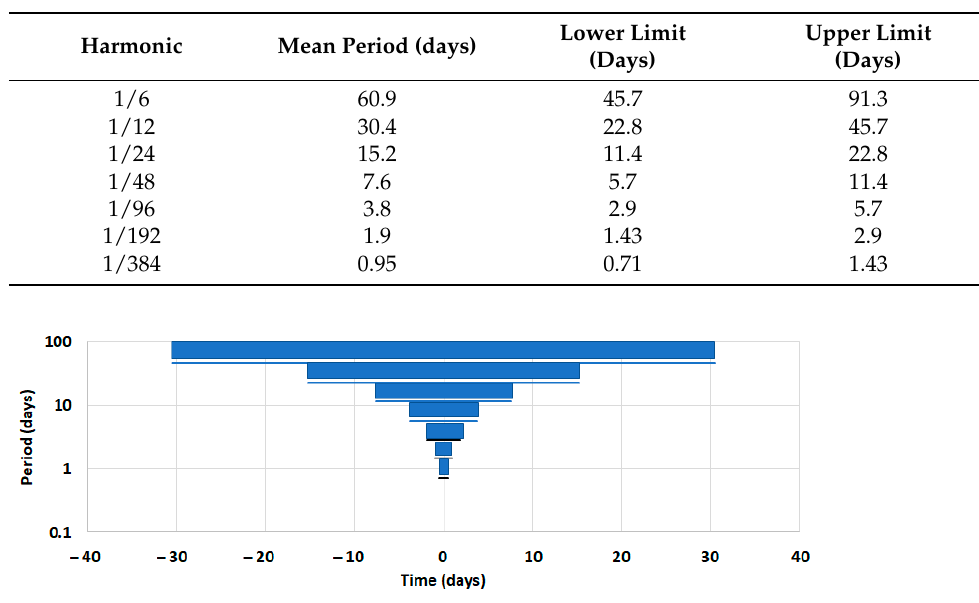
Table 1. Contiguous bandwidths used in wavelet analysis.